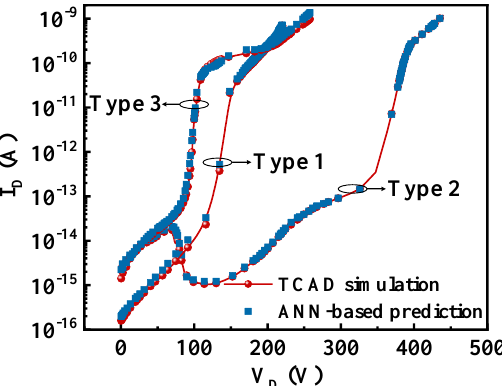
Figure 4. The predicted off-state I–V curve of the ANN-based framework.